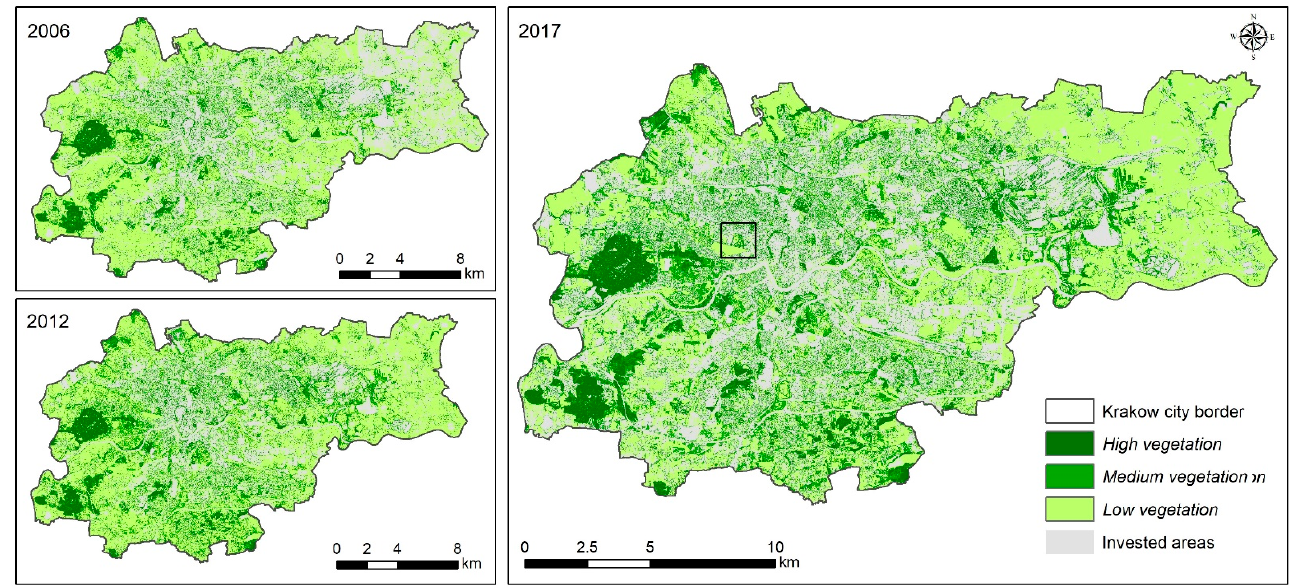
Figure 4. Results of Krakow vegetation classification for 2006, 2012, and 2017.